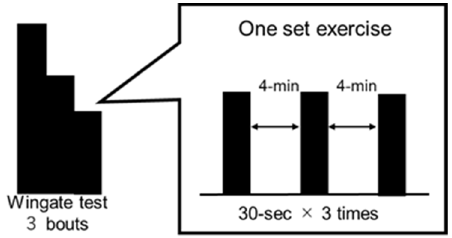
Figure 2. Wingate Figure 2. Wingate test.